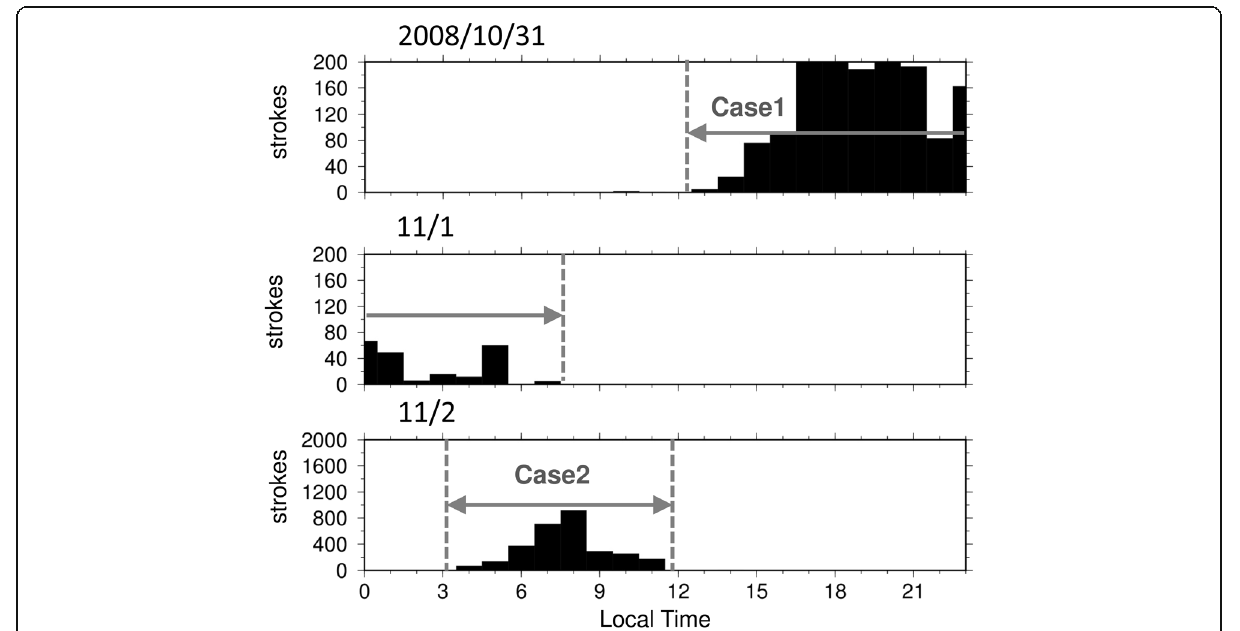
Fig. 3 Example of WL case selection based on time series graphs of lightning